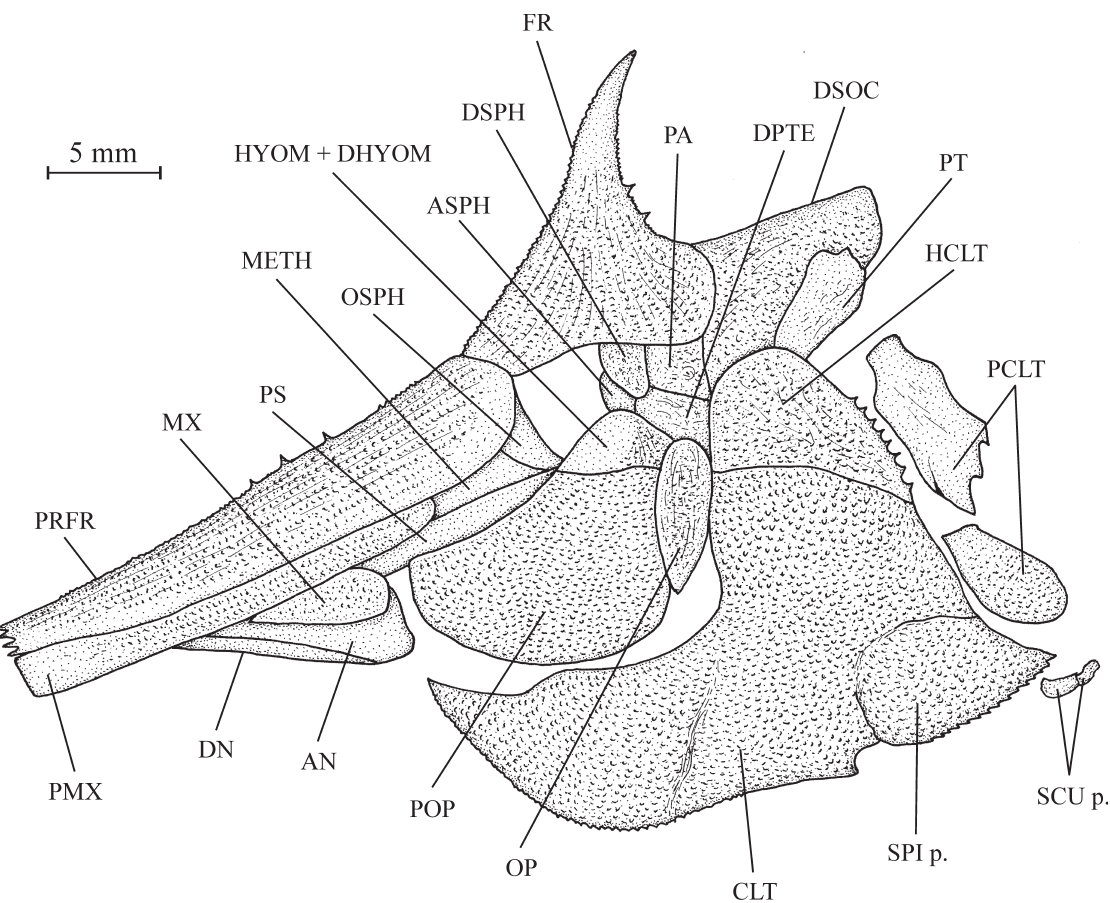
Fig. 19. Rostropycnodus gayeti gen. et sp. nov., paratype CLC S-337 Reconstruction of the skull based on the three